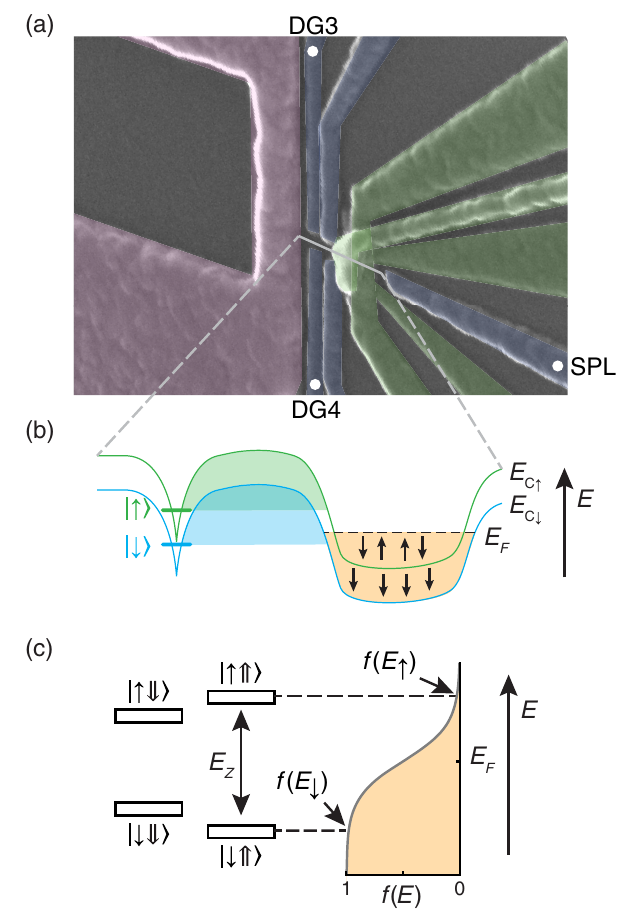
FIG. 1. (a) False-colored micrograph of a device from the same batch as the one used in this paper. The SET for electron spin readout and initialization is shown on the right in green. The microwave antenna, used for ESR and NMR, is shown on the left in pink. Pulsing gates DG3, DG4, and SPL (identified by white dots) form a virtual gate (VG). (b) Schematic energy landscape of the device. The donor binding potential confines an electron in the spin-down (blue line) or spin-up (green line) state. The conduction band edge is indicated for both spin-up ( E c ↑ ) and spin-down ( E c ↓ ) electrons, split by the Zeeman energy E Z . The green and blue shaded regions illustrate that j ↑ i and j ↓ i electrons are expected to face the same energy barrier to the reservoir upon elastic tunneling (see Sec. V). The electron is initially drawn from the SET island, shown in tan, which acts as a finite-temperature charge reservoir. (c) Level diagram of the electron-nuclear spin system (not to scale), alongside the occupied states in the SET island, which follow the Fermi-Dirac distribution f ð E Þ When E Z ≫ k B T e and the electrochemical potential of the donor is tuned about the Fermi level, a j ↑ i electron can tunnel to the reservoir at a rate Γ ↑ ; , which is high because out of the large density of empty states in the reservoir, i.e., 1 − f ð E ≈ 1 . Tunneling of a j ↓ i electron, at a rate Γ ↑ Þ ↓ ; out , is greatly suppressed by the lack of available states, 1 − f ð E ≪ 1 . ↓ Þ